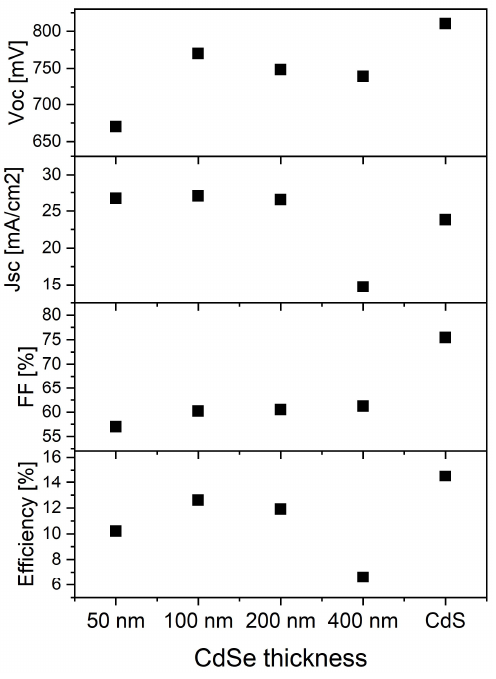
Figure 3. Performance of CdSe/CdTe solar cells with different CdSe thicknesses (values taken from Poplawsky et al. [16]).